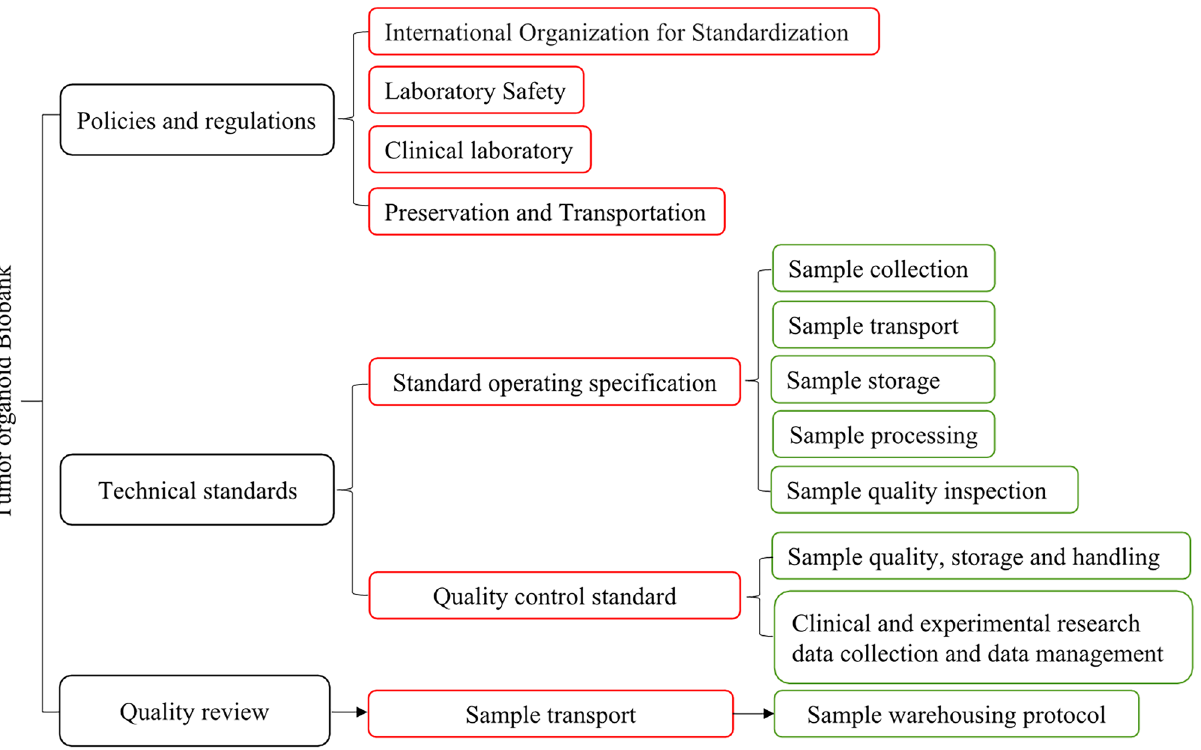
Figure 1. Management process and quality control system of organoid biobanks.